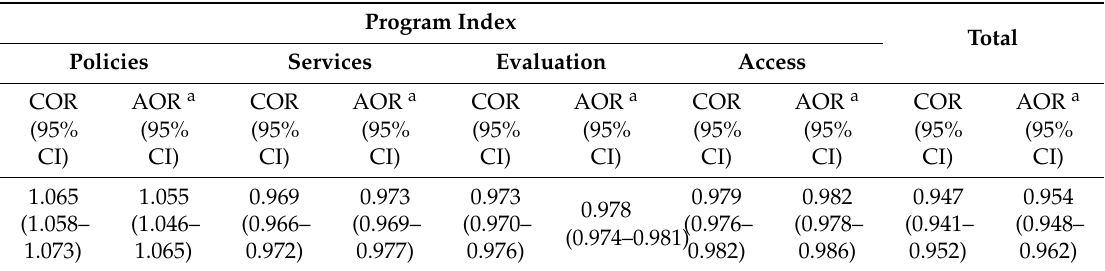
Table 3. Odds ratios and 95% confidence interval of contraceptive use in relation to program index scores in Kenya from 1989 to